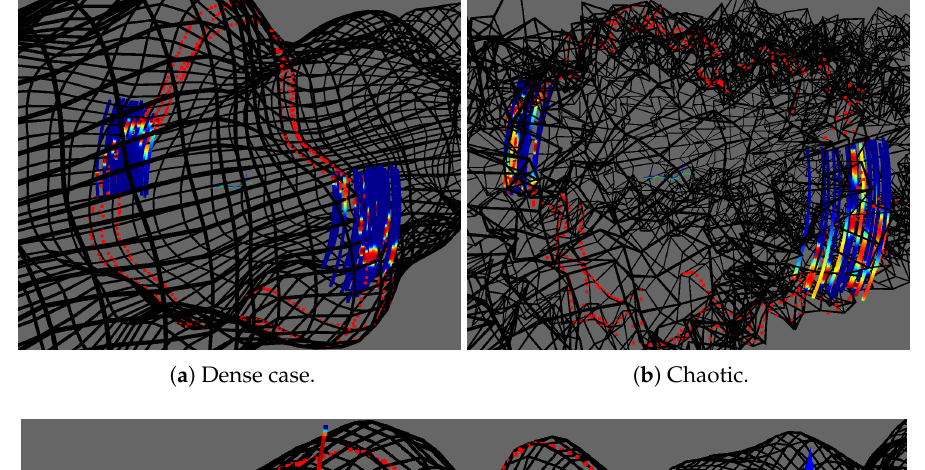
Figure 17. Distributions obtained in the experiment with K s = K M distribution are not